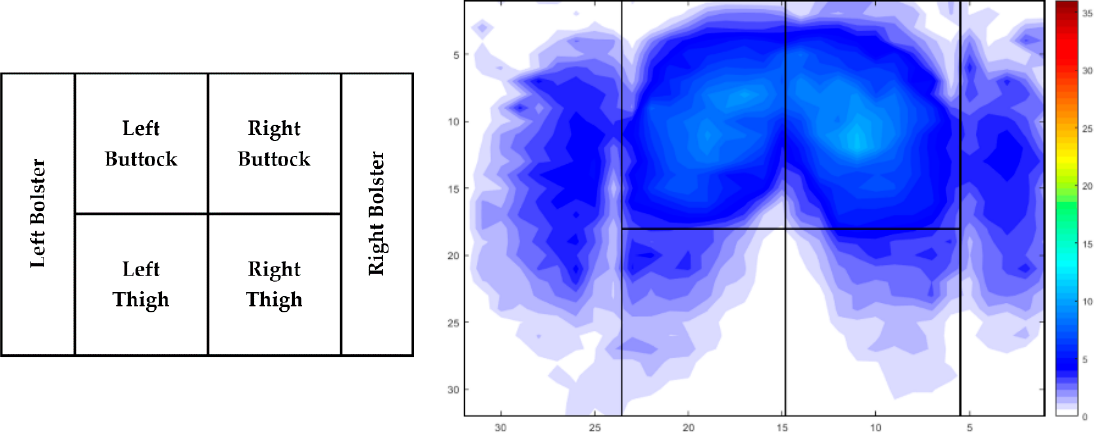
Figure 1. Definition of lower limbs